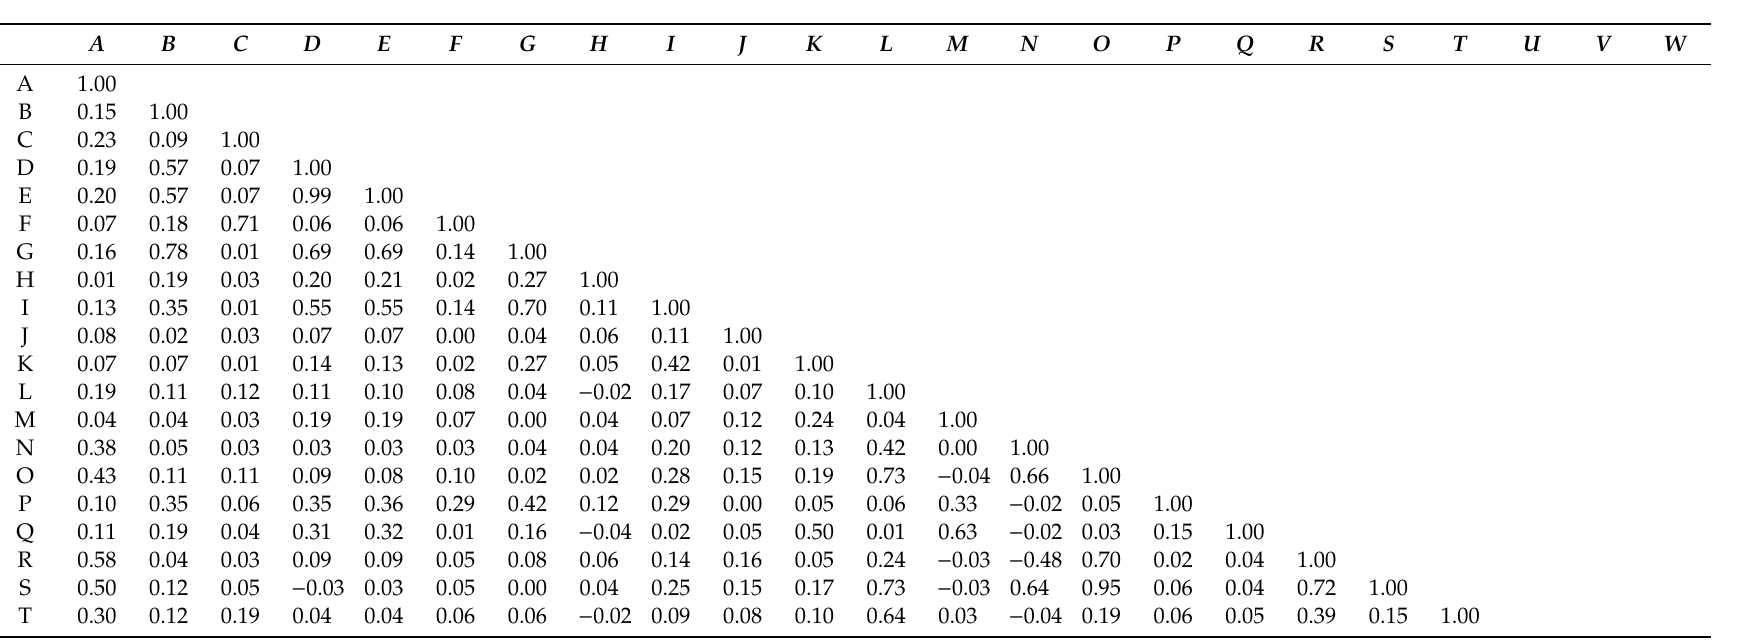
Table A4. Correlation matrix for TVI